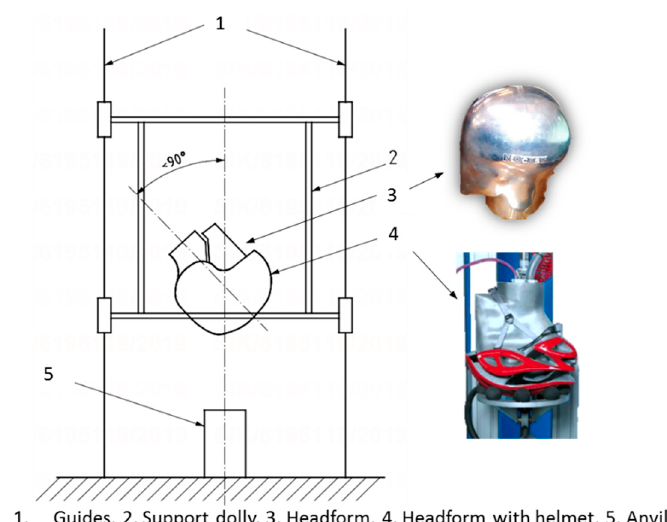
Figure 4. The test rig for the guided free fall impact test in accordance with the EN 1078 and using EN 960 magnesium headform.